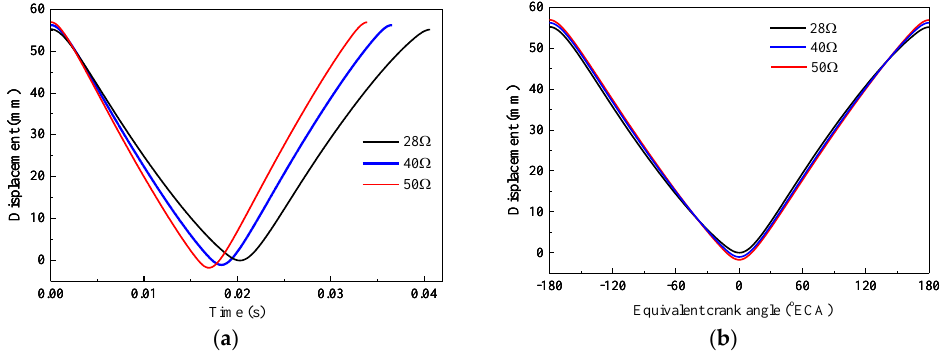
Figure 6. ( a ) The piston displacement at different external load resistance corresponding to time; ( b ) the piston displacement at different external load resistance corresponding to the ECA.